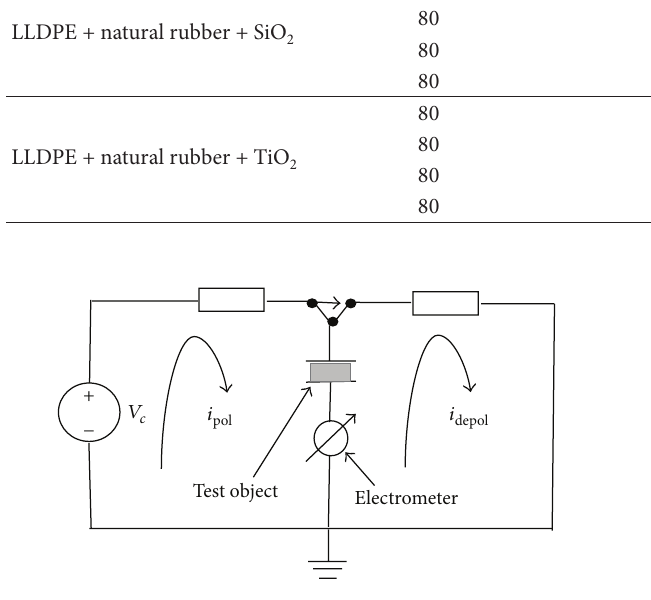
Figure 1: PDC measurement concept.